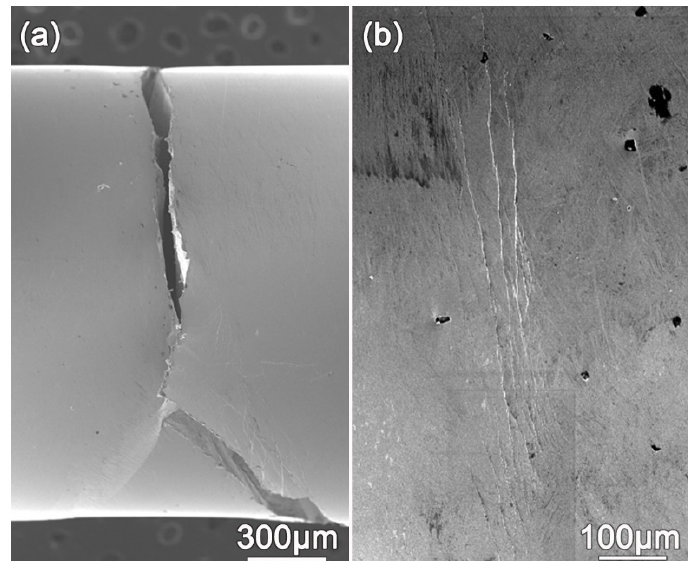
Figure 4. Fatigue crack initiation shown on the side surface of fractured Zr 61 Ti 2 Cu 25 Al 12 BMG specimen tested at the stress amplitude of 460 MPa. ( a ) The SEM image shows that the fatigue crack initiated at a shear band. ( b ) A flock of shear bands on the side surface of the specimen far away from the fracture surface.